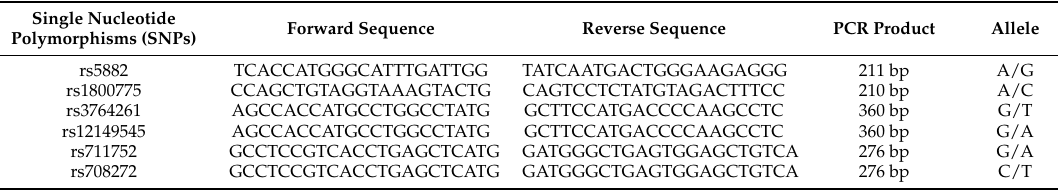
Table 1. Sequences of forward and reverse primers for genotyping of the CETP gene. Single Nucleotide Polymorphisms